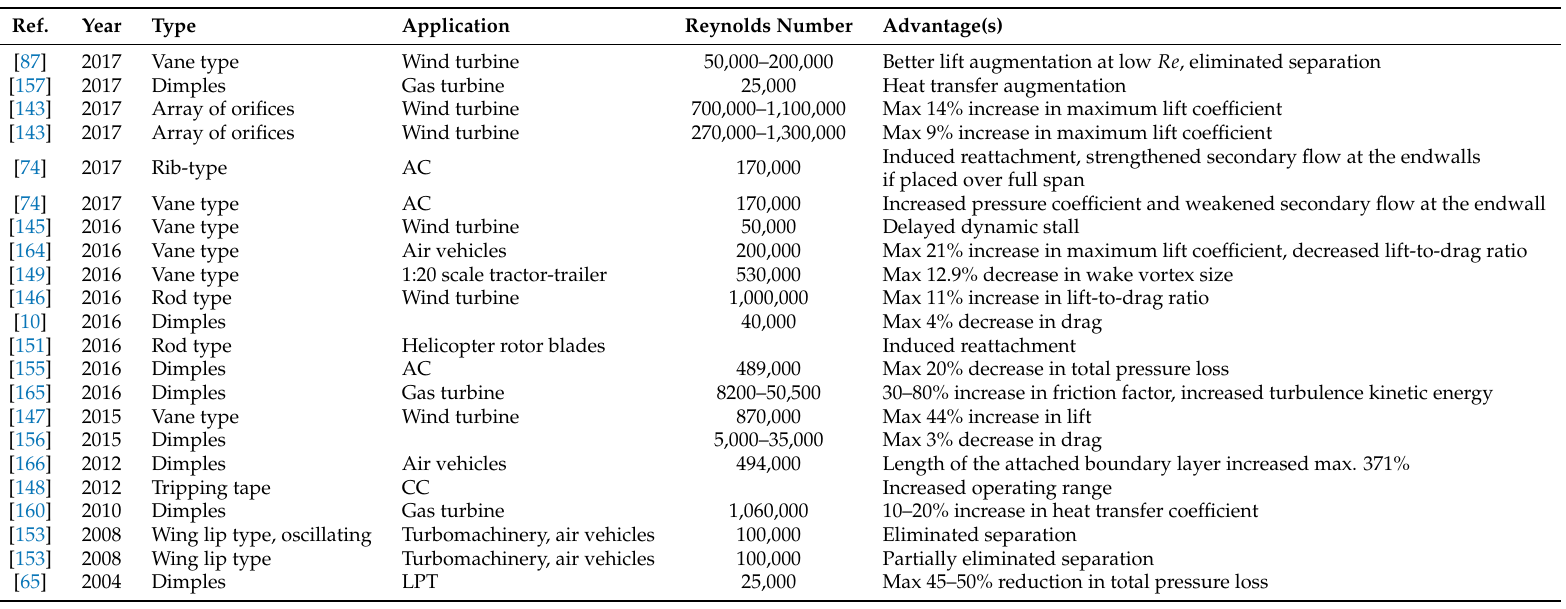
Table 9. Representative summary of vortex generator